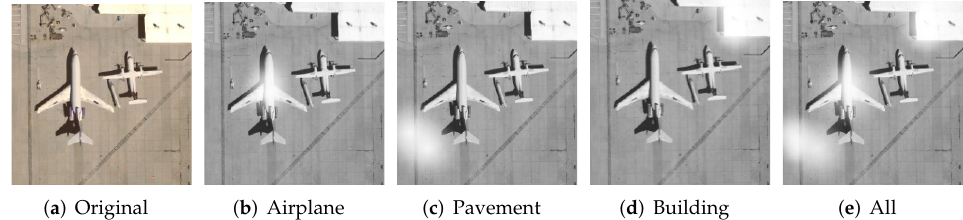
Figure 6. The picture “airplane79” in UC-Merced [16,17] dataset and its attention parts generated by RMAM.